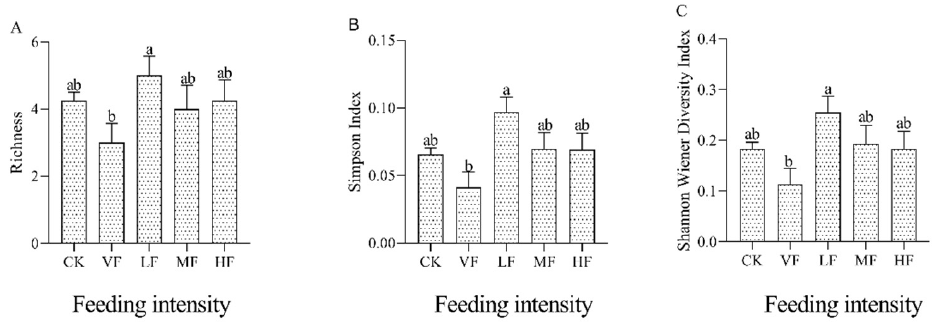
Figure 2. Diversity of plant communities in different foraging intensities (CK, no foraging; VF, very little foraging; LF, light foraging; MF, moderate foraging; HF, heavy foraging) showing ( A ) richness, ( B ) Simpson index, ( C ) Shannon–Wiener diversity index. In each graph, means with the same lowercase letters are not significantly different among foraging intensity ( p > 0.05); means with different lowercase letters are significantly different among foraging intensity ( p < 0.05). Capped lines represent ± standard error.